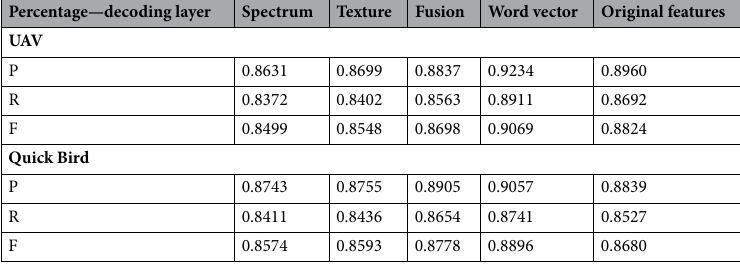
Table 5. Effect of the different labelling methods on the evaluation criteria values.